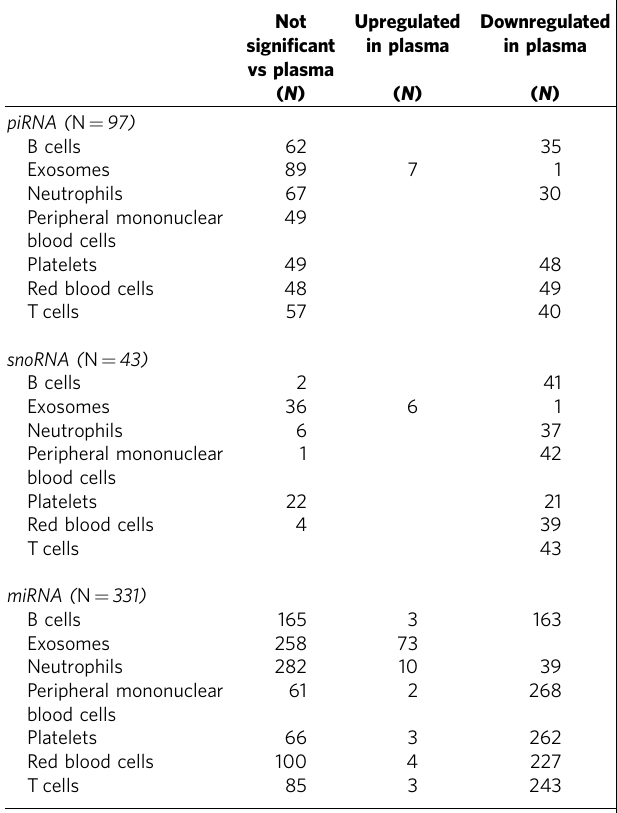
Table 2 | exRNA expression in each cell type relative to isolated